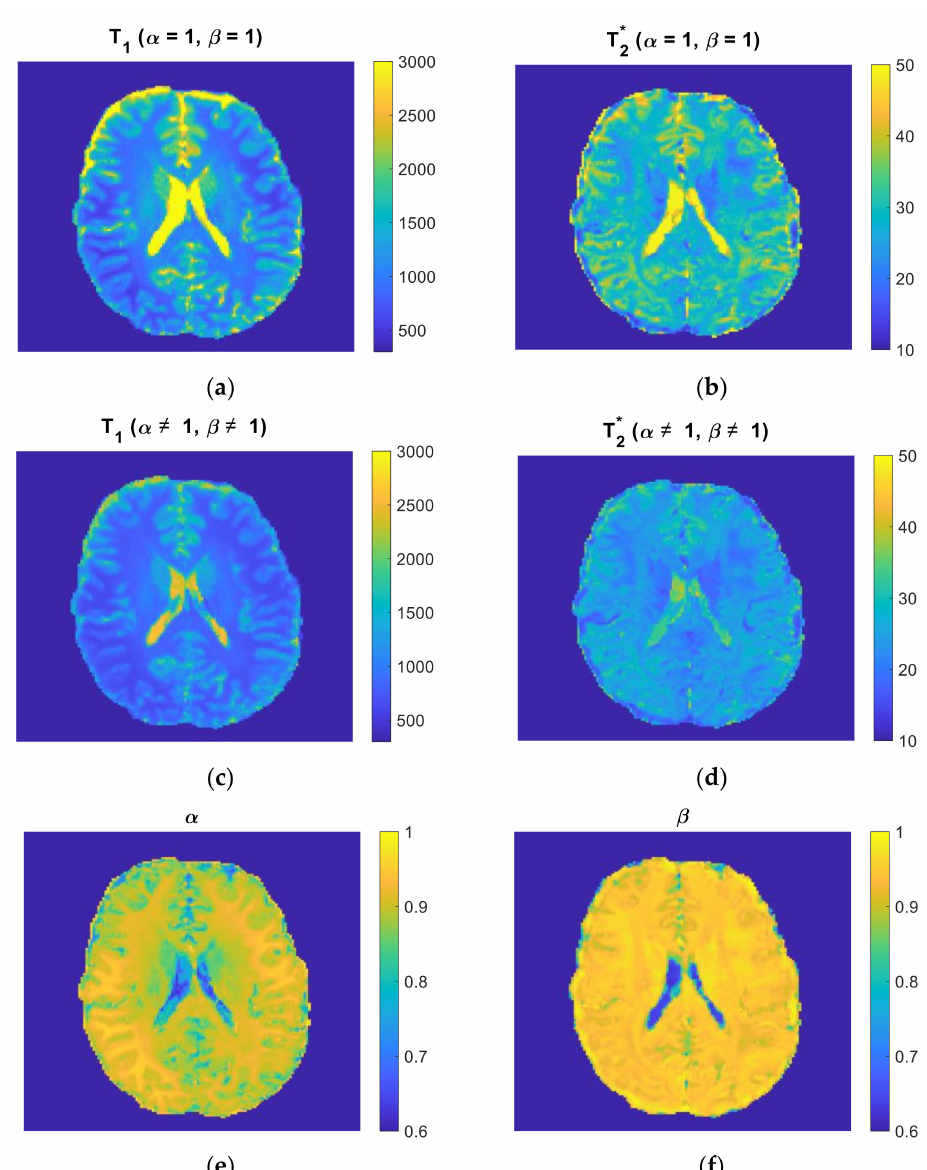
Figure 6. An example of spatially resolved maps of model parameters (slice 35, participant 2). Displayed are ( a ) T 1 and ( b ) T ∗ for the integer order model. Additionally, time fractional order 2 parameter model parameters ( c ) T 1 , ( d ) T ∗ , ( e ) α and ( f ) β are 2